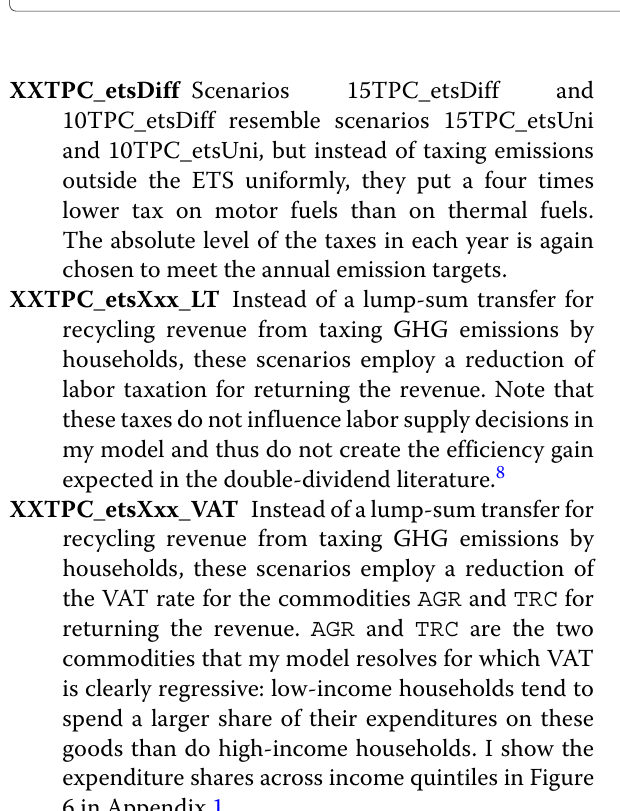
Fig. 1 Distribution of fossil fuel expenditure share within and across income quintiles in 2015 ( a ) and 2050 ( b ). Note: Income quintiles are according to allocation by statistical office. Circles show mean